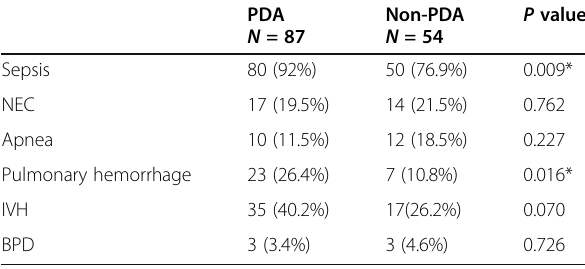
Table 2 Comorbidities of the studied